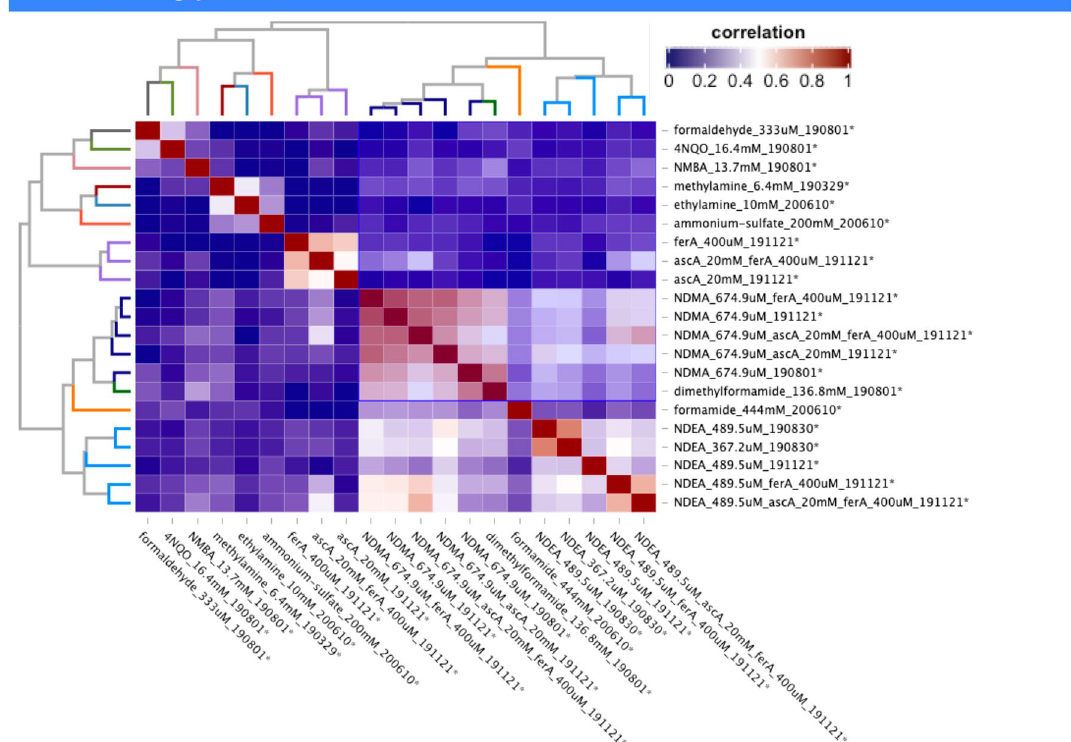
Figure 11. Hierarchical cluster analysis of the all 22 chemogenomic screens. Pearson correlation was used to generate the “coinhibitory” square matrix and Ward was used as the distance. Branch colors on the two identical dendrogram indicate the three major clusters. Compounds within each cluster are highly correlated as indicated by the color scale as well as the dendrogram height and may correspond to compounds that have similar chemogenomic profiles and therefore may suggest similar mechanism of action. For example, the fitness profiles for NDEA all cluster tighter as expected (orange dendrogram branch color). Globally, two of the three major clusters (orange and navy branches in dendrogram) that include NDMA, NDEA, DMF and formamide exhibit significant correlation (visualized as darker red region in the heatmap). This finding is consistent with the chemogenomic profile similarity between these compounds, all of which were enriched for the genes involved in the arginine biosynthetic pathway. Figure was generated using the Bioconductor v3.12, https:// www. bioco nduct or.